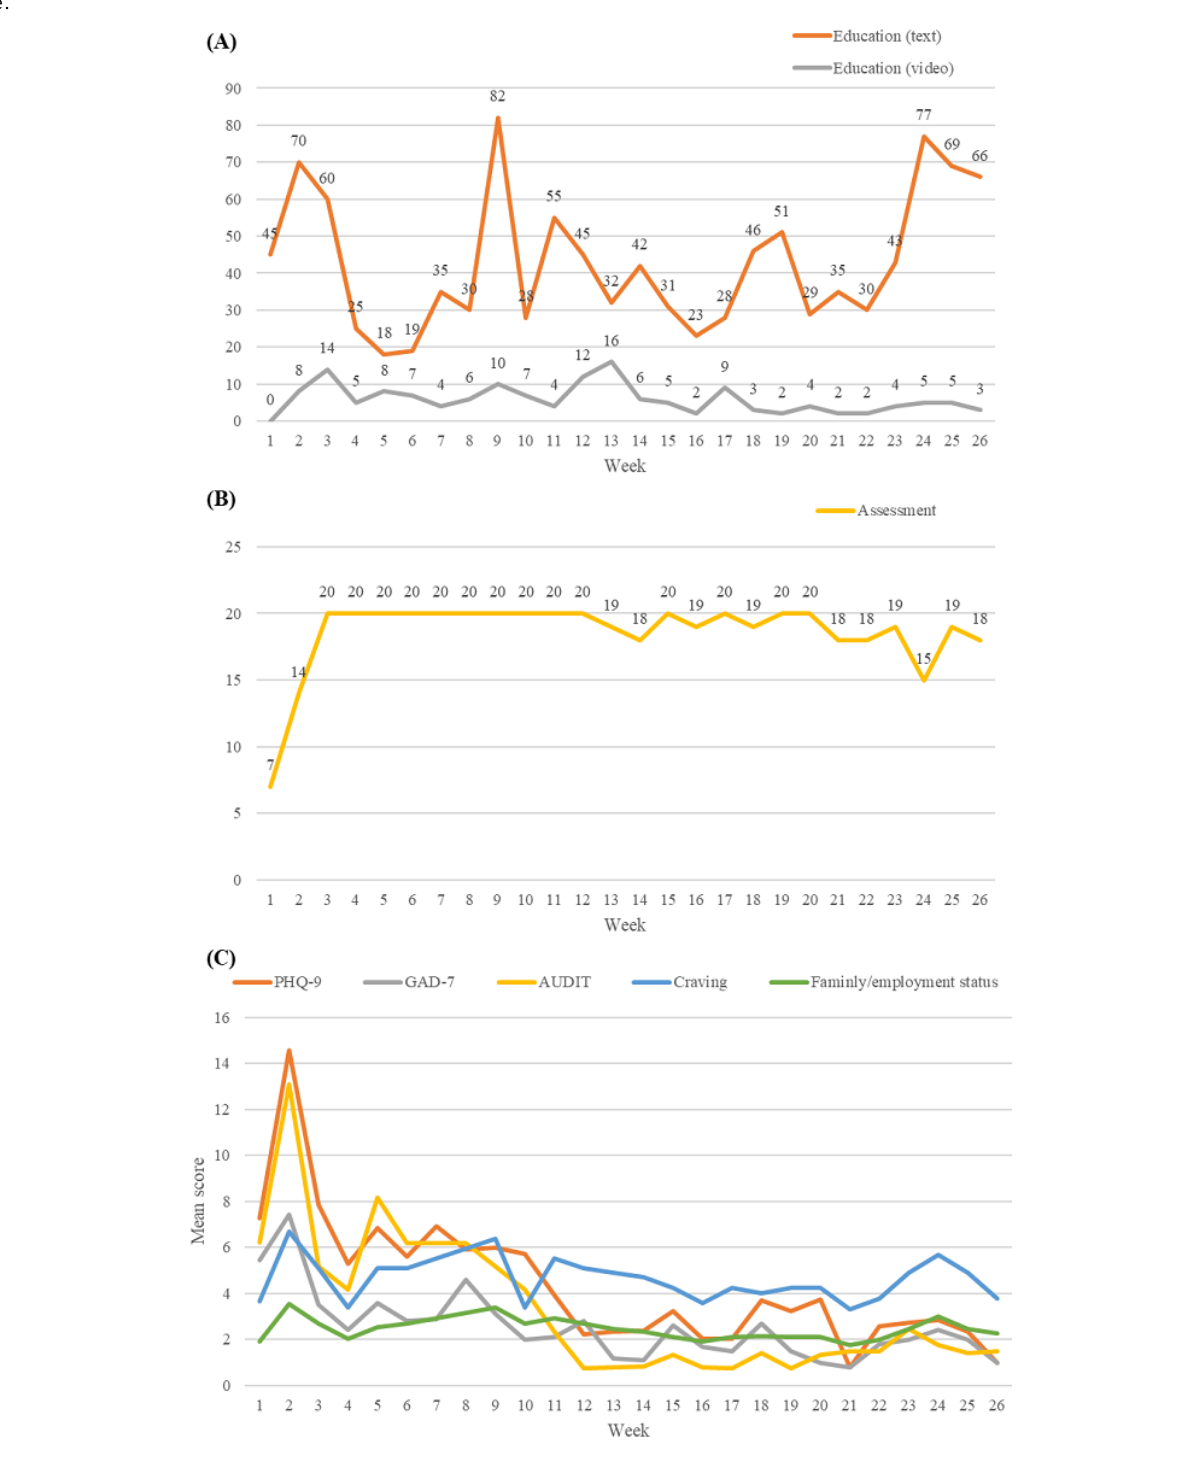
Figure 4. (A) Total number of people using education (in the form of text or video) function from CAREs app per week; (B) number of unique users who used assessment function from CAREs app per week (maximum number of people was 20); (C) mean scores of assessment results decreased over